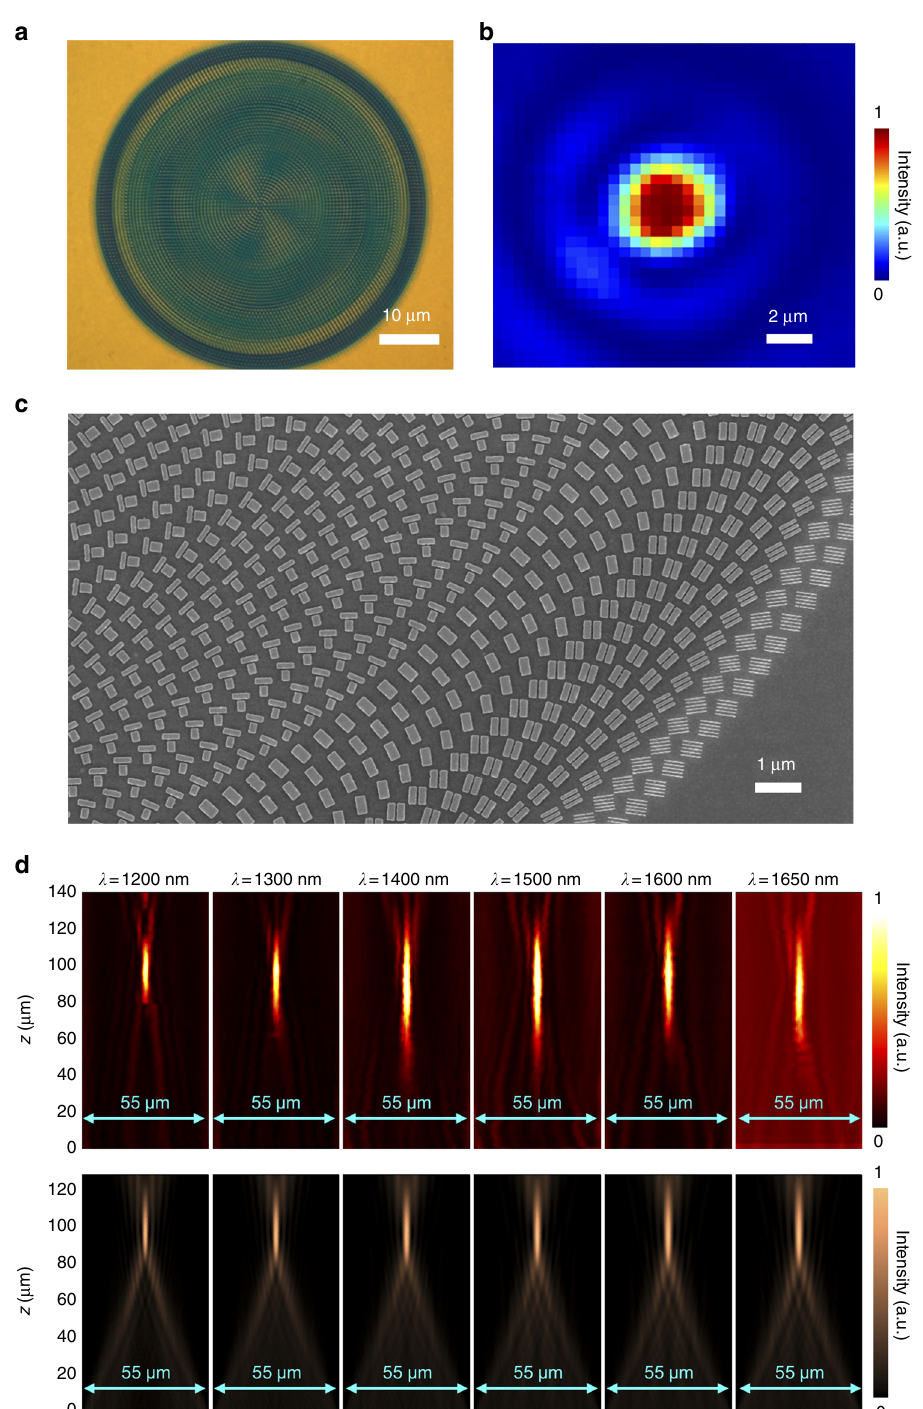
Fig. 3 Veri fi cation of achromatic converging metalens. a Optical image of fabricated metalens with NA = 0.268. b Measured light intensity of focal spot at incident wavelength λ = 1500 nm. c Zoom-in scanning electron microscope (SEM) image of fabricated metalens. More images and design details can be found in the Supplementary Note 3. d Experimental ( top row ) and numerical ( bottom row ) intensity pro fi les of BAML along axial planes at various incident wavelengths while incident wavelength varies, indicating the realization of a polarization (RCP) to left-hand circular polarization (LCP) light broadband achromatic converging property in near-IR region. intensity pro fi les on x – z plane is subsequently obtained from For optical characteristics of the designed metalens, the focal stitching all captured images together. Figure 3d shows that the lengths vs. incident wavelength of both achromatic and chromatic measured and simulated light intensity pro fi les along the cross metalenses are measured. Figure 4a shows the results of three section plane are in a good agreement with each other. As the- achromatic metalenses with different NA values, which exhibits oretical predication, the focal length keeps almost unchanged NATURE COMMUNICATIONS | 8: